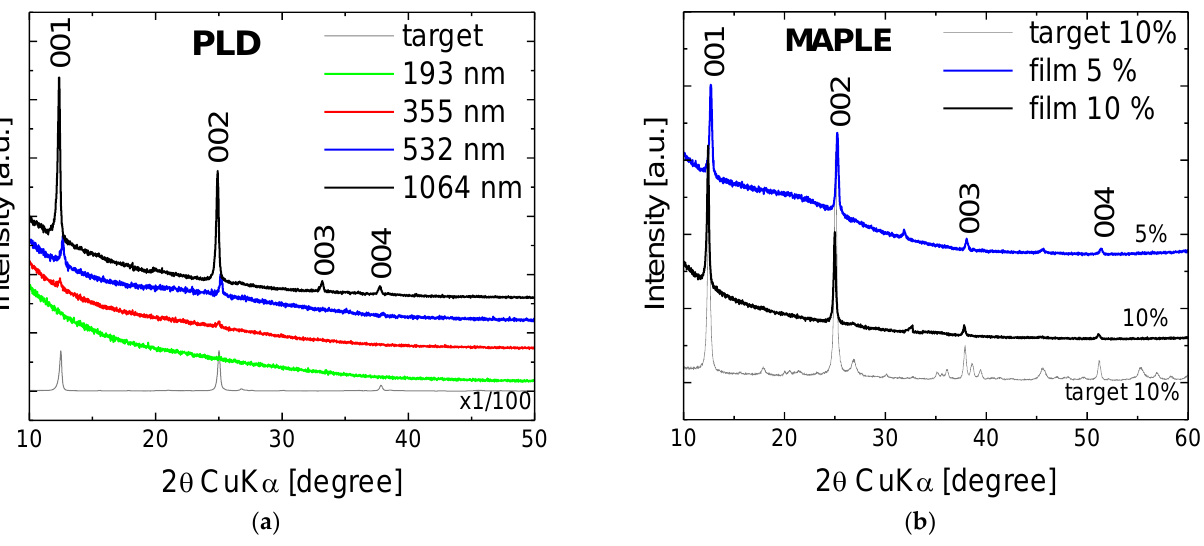
Figure 4. XRD patterns of the films deposited by PLD ( a ) and MAPLE ( b ) and their corresponding targets. In the XRD patterns of MAPLE films (Figure 4b and Table 4) all the four (00 l ) reflections